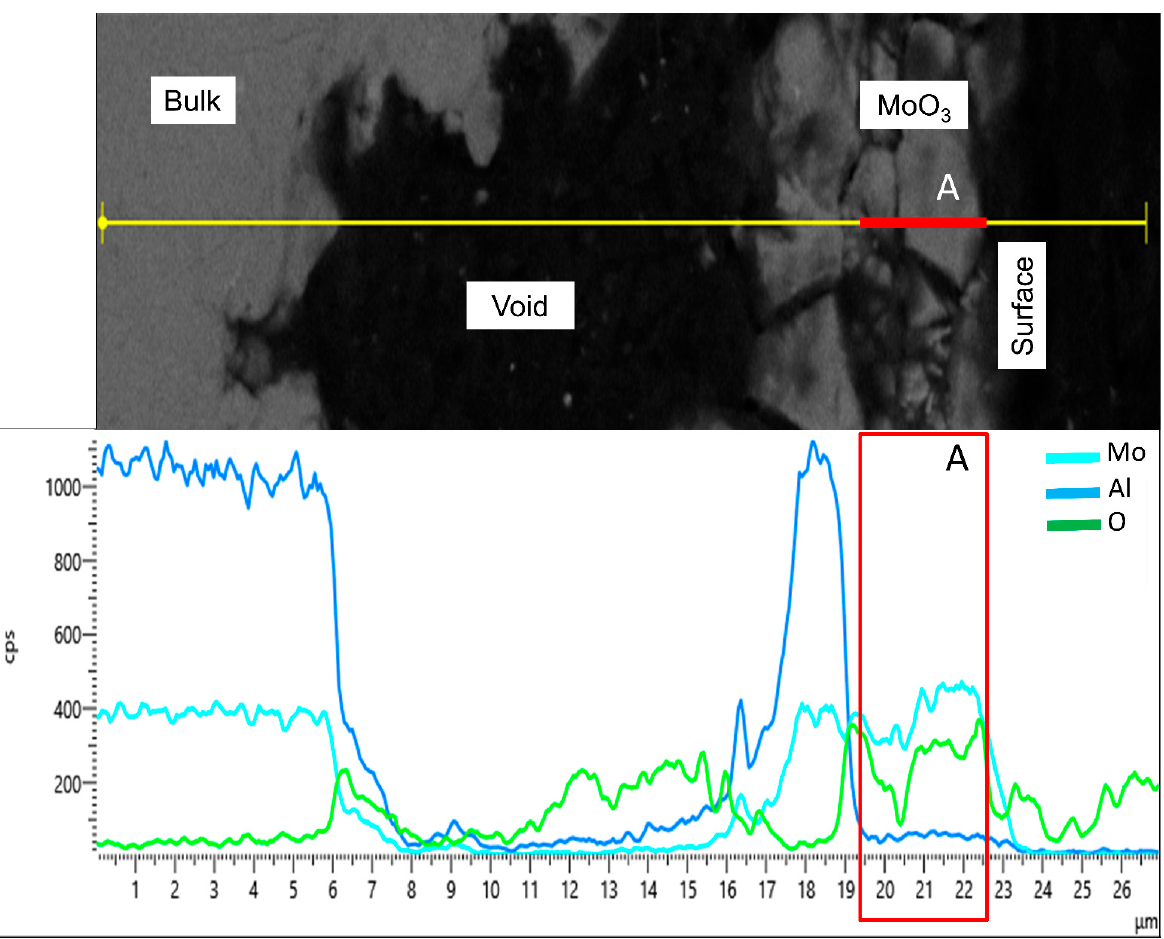
Figure 5. EDS line scan of SS_HF: blue signal for Al, cyan for Mo and green for O.